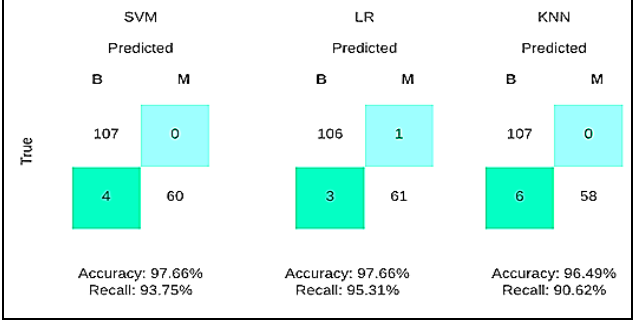
Figure 3. Confusion matrix outcomes of three models with total features.